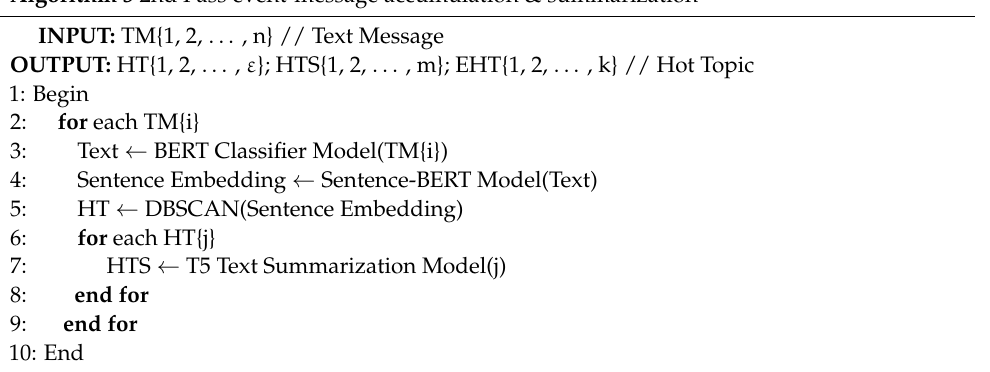
Algorithm 3 2nd Pass event-message accumulation &